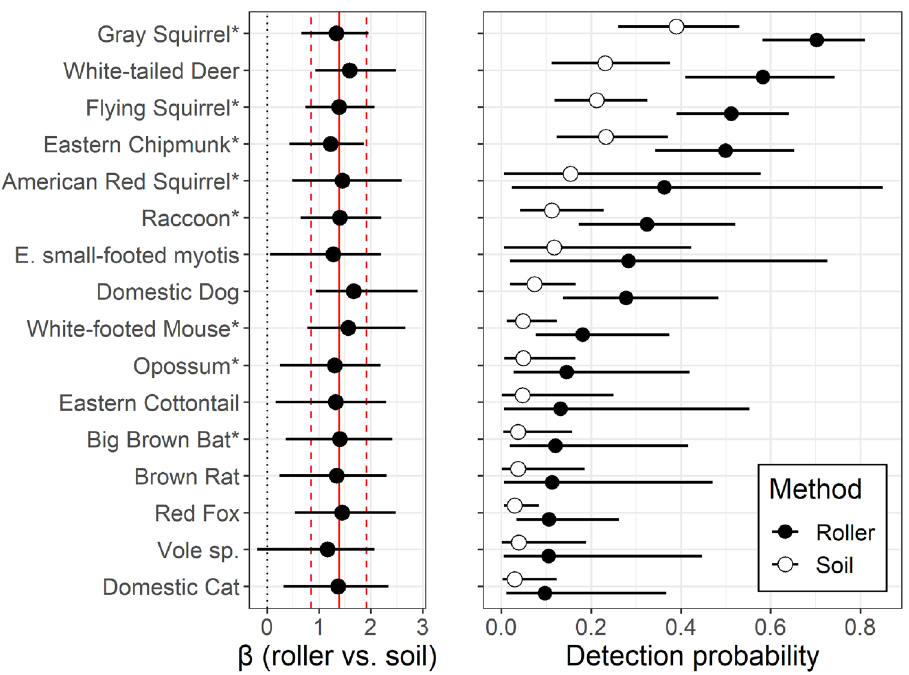
Figure 4. Results of a community occupancy model of mammal species detected in a tree bark surface (‘roller’) and soil eDNA metabarcoding study in New Jersey, USA woodlands. The left panel shows estimated slope coefficient for the effect of sampling method (roller vs. soil) on detection probability for each species (solid circles with 95% credible intervals) and for all species combined (solid vertical line with dashed lines indicating 95% credible intervals). A slope above zero (gray vertical dotted line) indicates higher detection probability for roller samples compared with soil samples. The right panel shows the model-estimated detection probability for each species with roller methods (solid circles) and soil (open circles) eDNA collection methods. Arboreal species are indicated with an asterisk